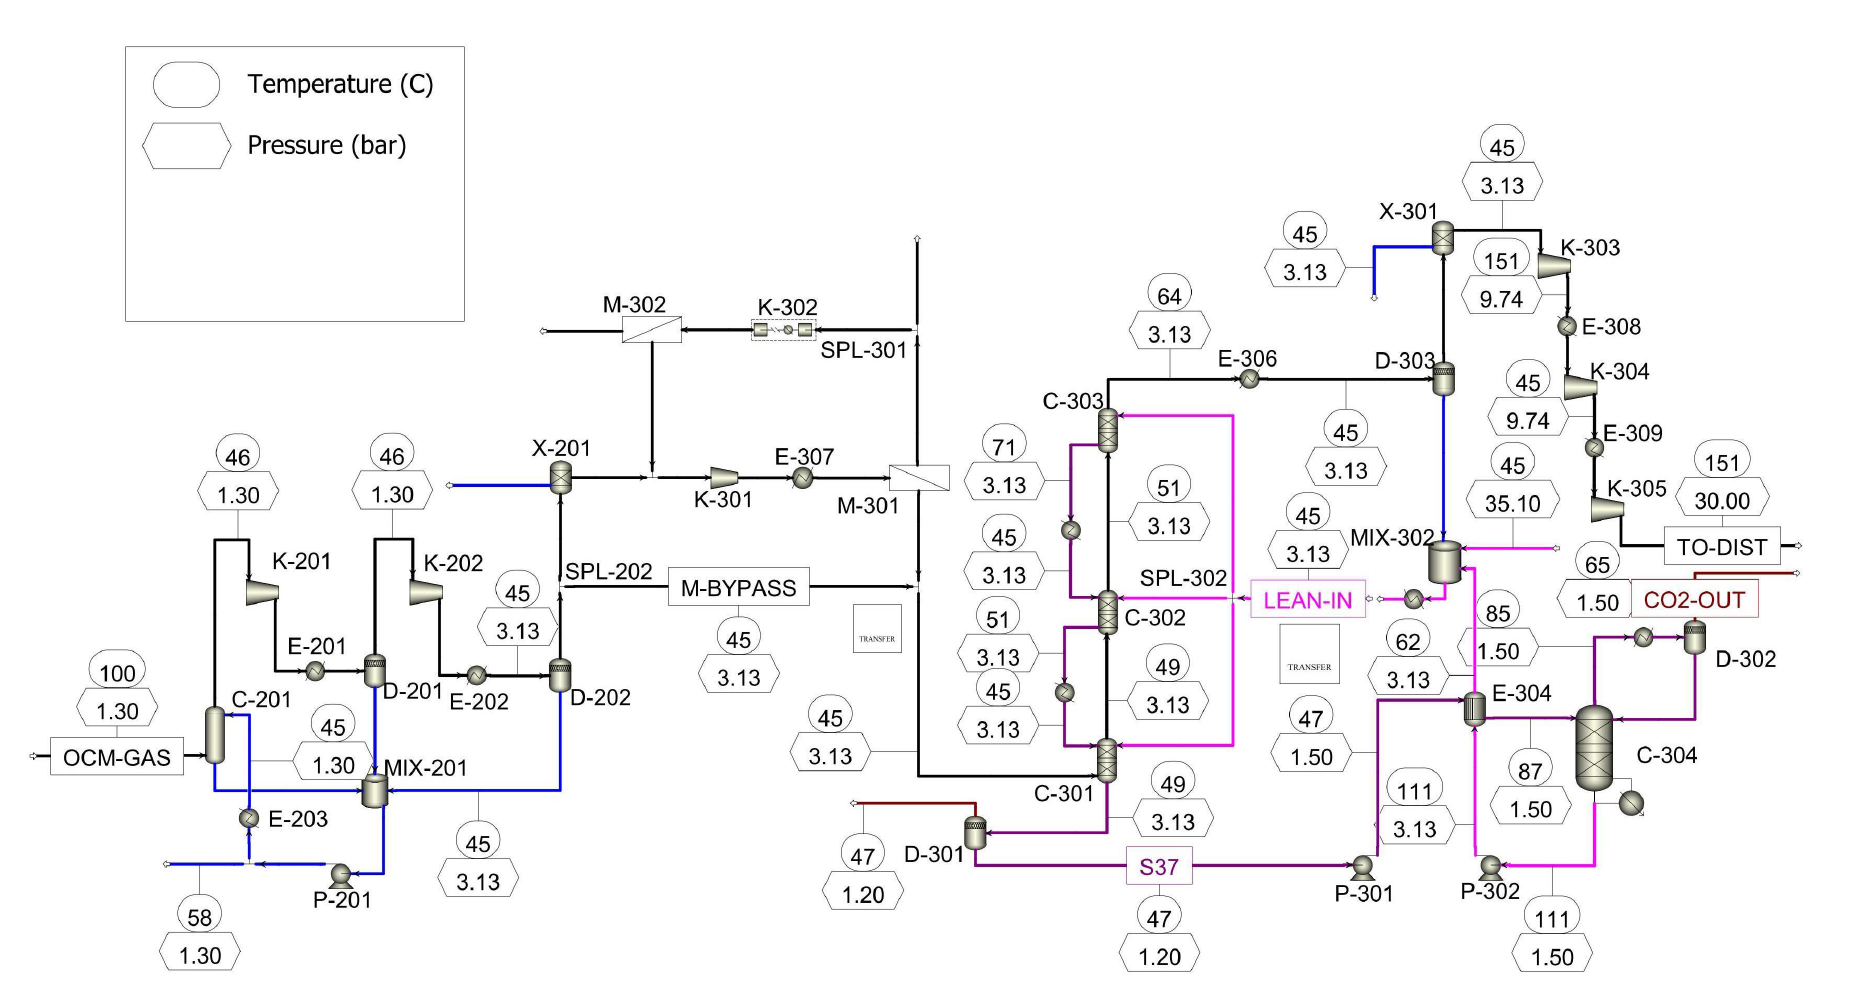
Figure 6. Process simulation with optimal process structure and operating conditions for the CO 2 removal section of the Bio-OCM plant using only absorption. Reproduced with permission from Penteado, Ph.D. Thesis, TUB, 2021